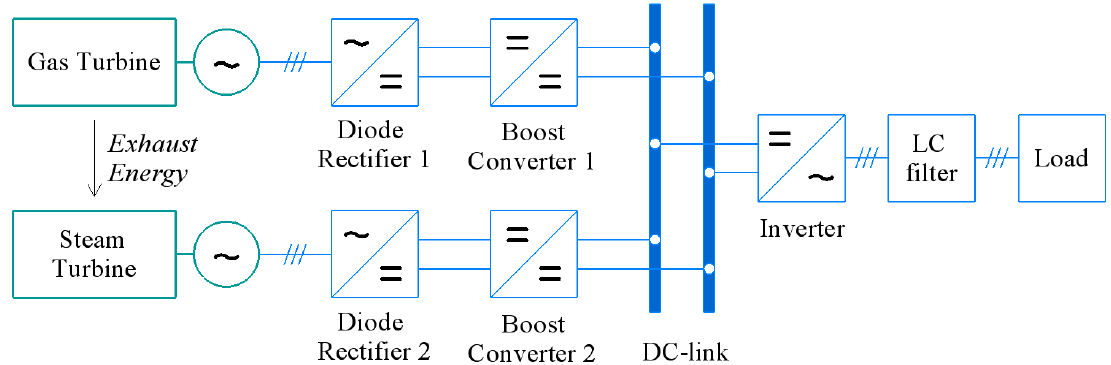
Figure 7. Electrical design of the binary energy system.